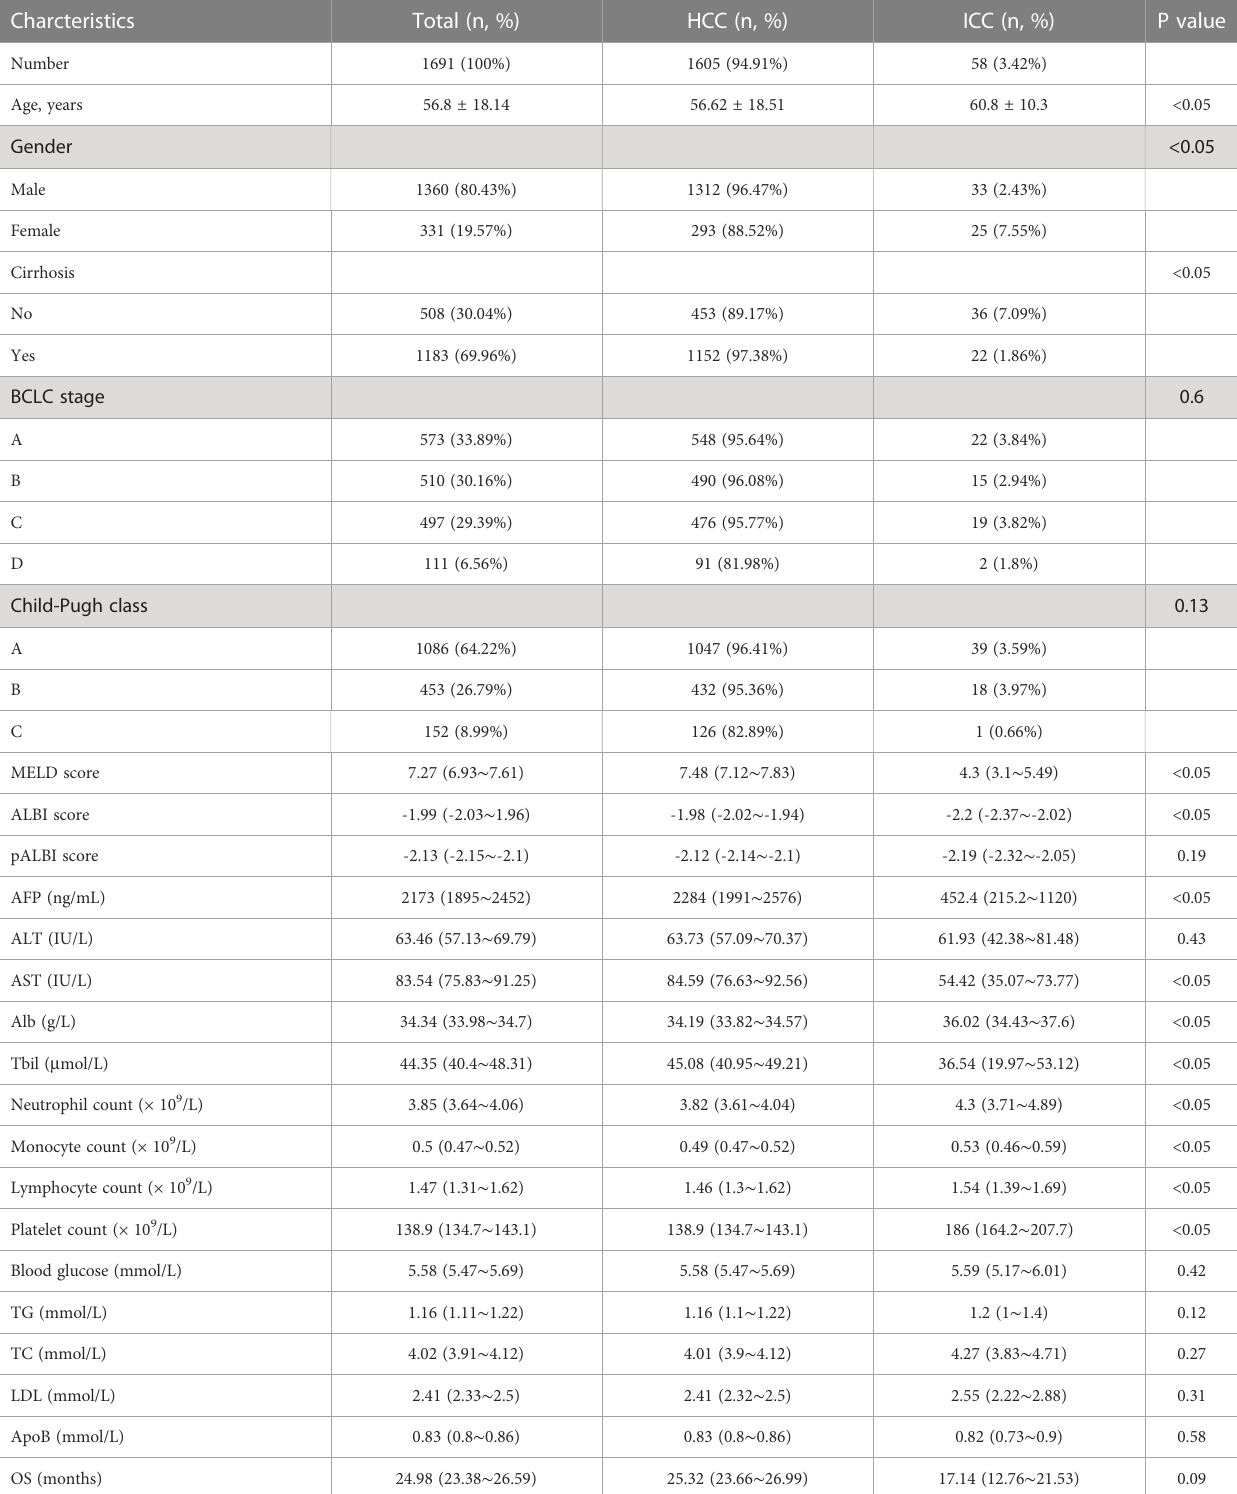
TABLE 1 Clinical characteristics of PLC patients.